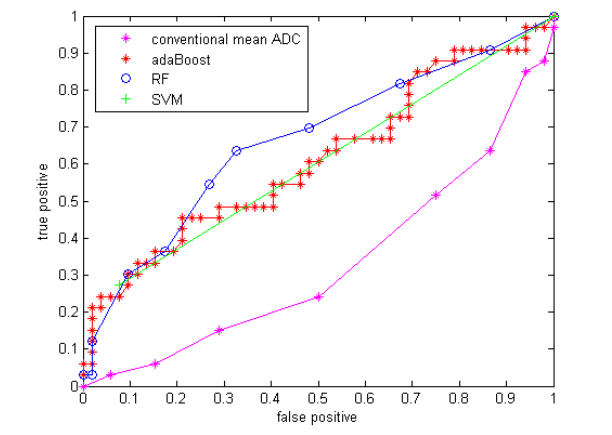
Figure 4. ROC curve for three classifiers without GMM